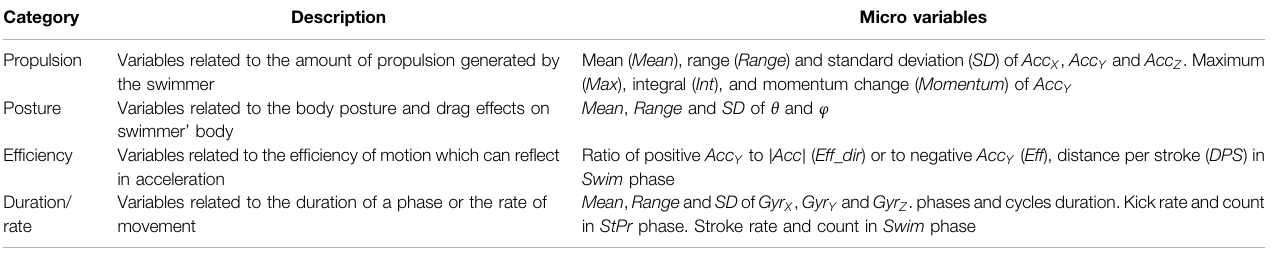
TABLE 2 | Categories and description of the phase-based micro variable de fi ned on IMU data in global frame. The name of the functions used for micro variables extraction are abbreviated in parentheses. Category